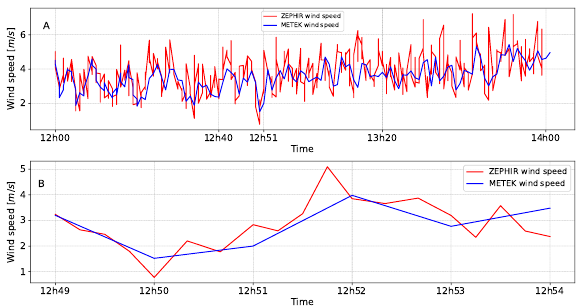
Figure 7. A : Horizontal wind speed (in m/s) during 1 hour before and 1 hour after the airborne flight. B : Horizontal wind speed (in m/s) zoomed around 12h51, the image acquisition